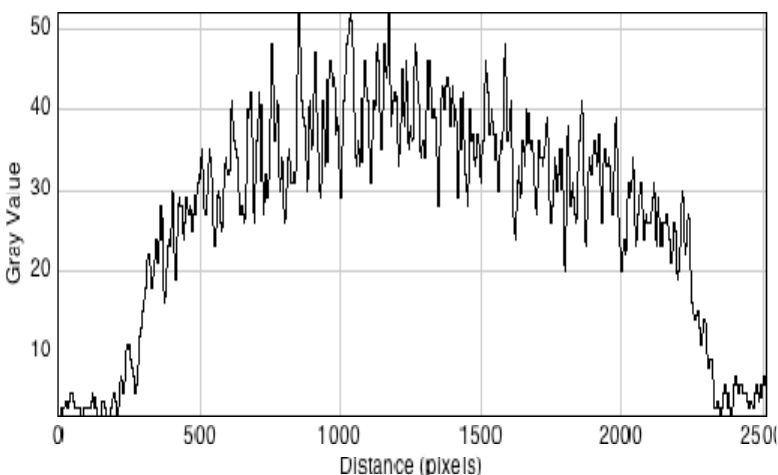
Figure 2. Typical signal profile through the centre of a Teflon block (100% beam hardening correction at